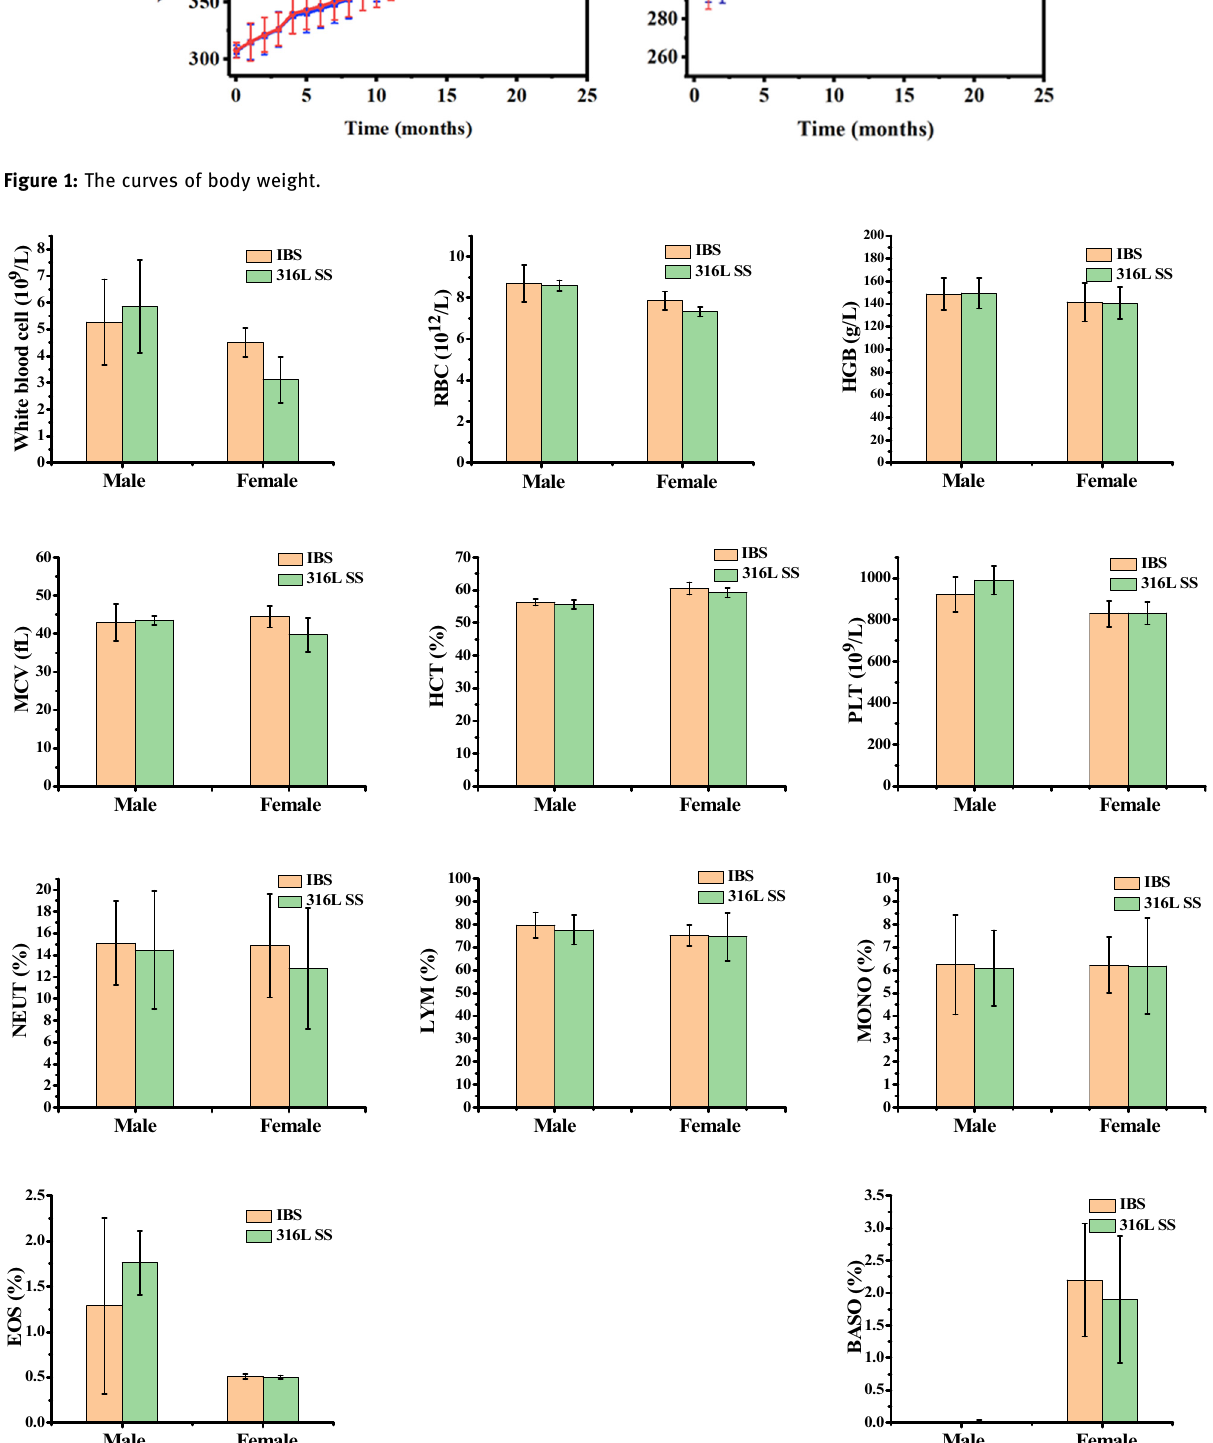
Figure 2: Hematology